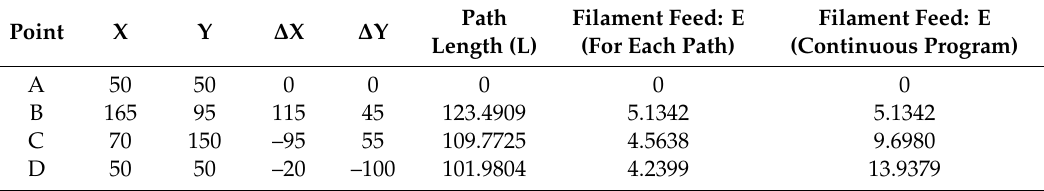
Table 1. Point coordinates, path length, and calculation of filament feed for each